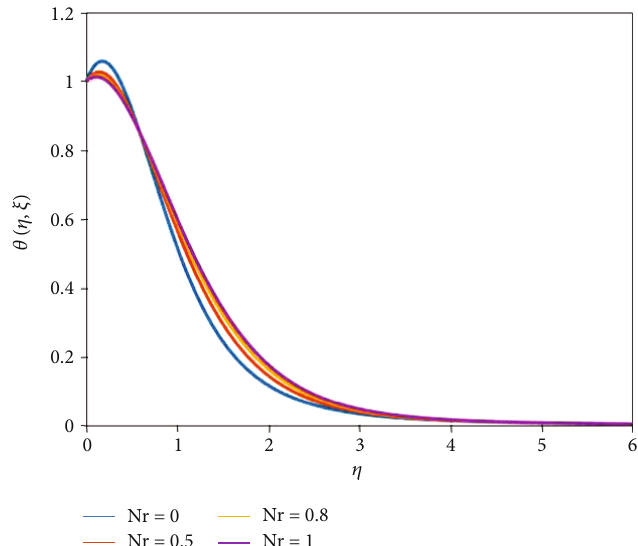
λ = 0 : 1, N = 0 : 5, n = 0 : 5, f r when